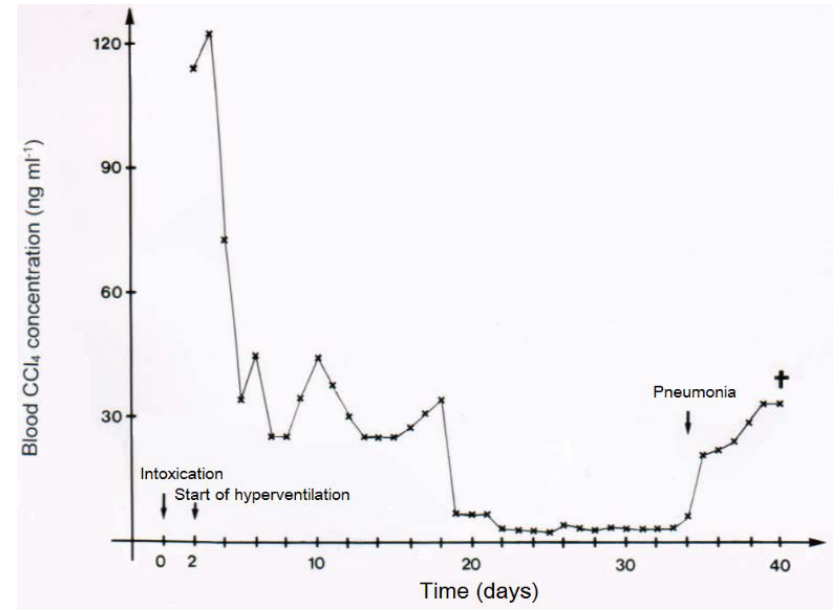
Figure 12. In another patient (case 9) intoxicated by oral use of 50 mL CCl 4 , blood levels of CCl 4 declined under the hyperventilation therapy and reached a plateau that lasted for around 16 days before a striking increase of blood levels was observed, due to impaired CCl 4 elimination via the lungs as a consequence of an emerging pneumonia with fatal outcome, reproduced with permission from [10]. Copyright Springer, 1983.